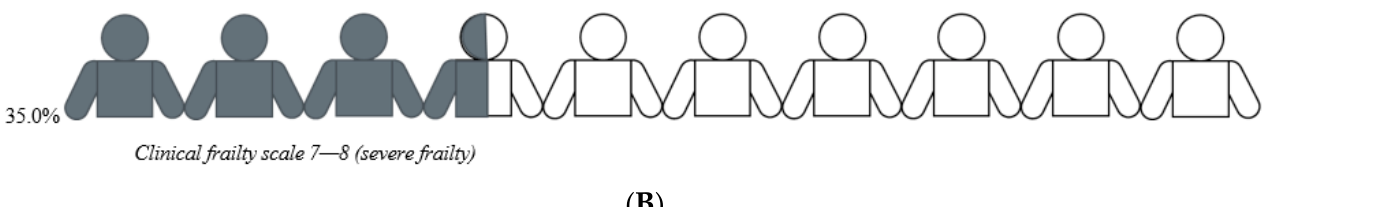
Figure 2. ( A ) Receiver operating curve: Clinical frailty scale and poor outcome. ( B ) Receiver oper- ating curve: Clinical frailty scale and permanent nursing home admission.